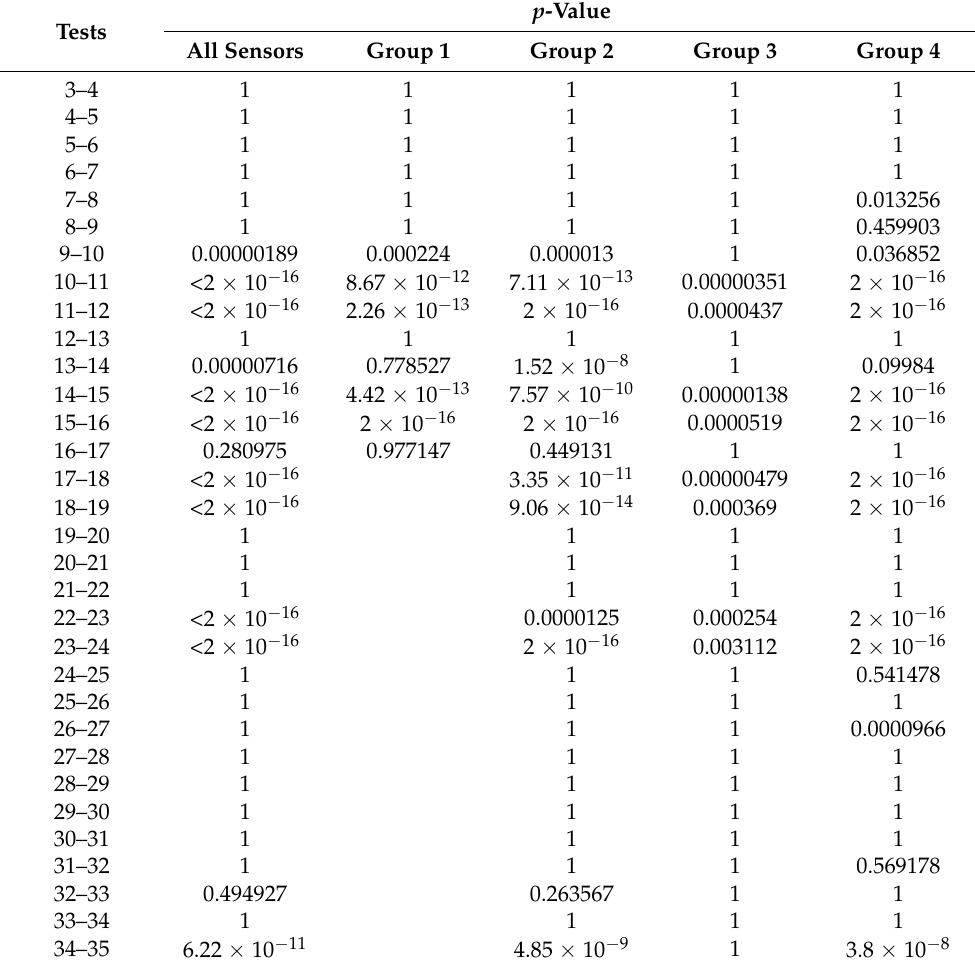
Table 5. Pairwise analysis between consecutive tests— p